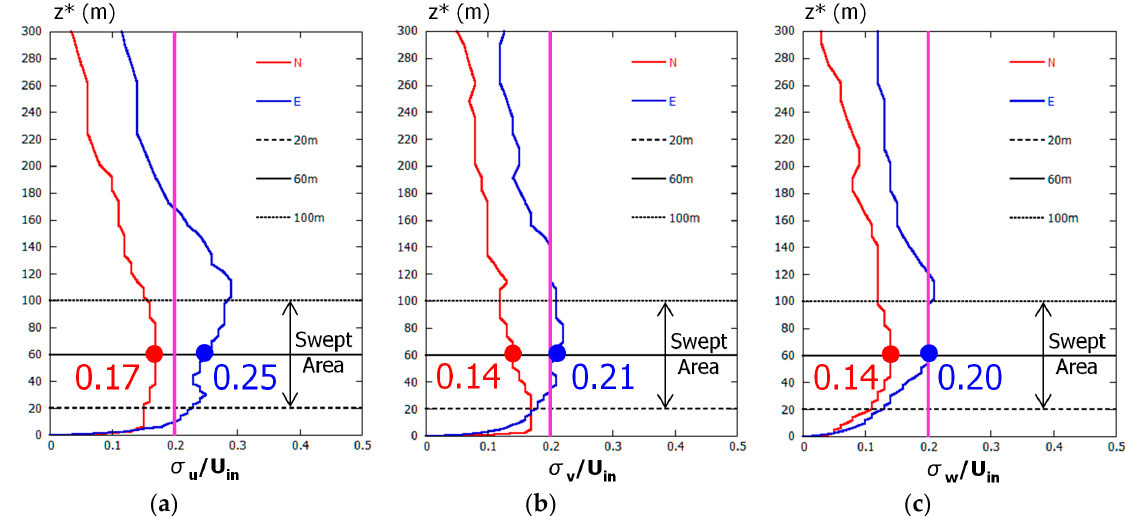
Figure 23. Vertical profiles of the non-dimensional standard deviations at wind turbine #10, with a time-averaged flow field. Red: northerly wind, Blue: easterly wind. ( a ) Streamwise direction. ( b ) Spanwise direction. ( c ) Vertical direction.